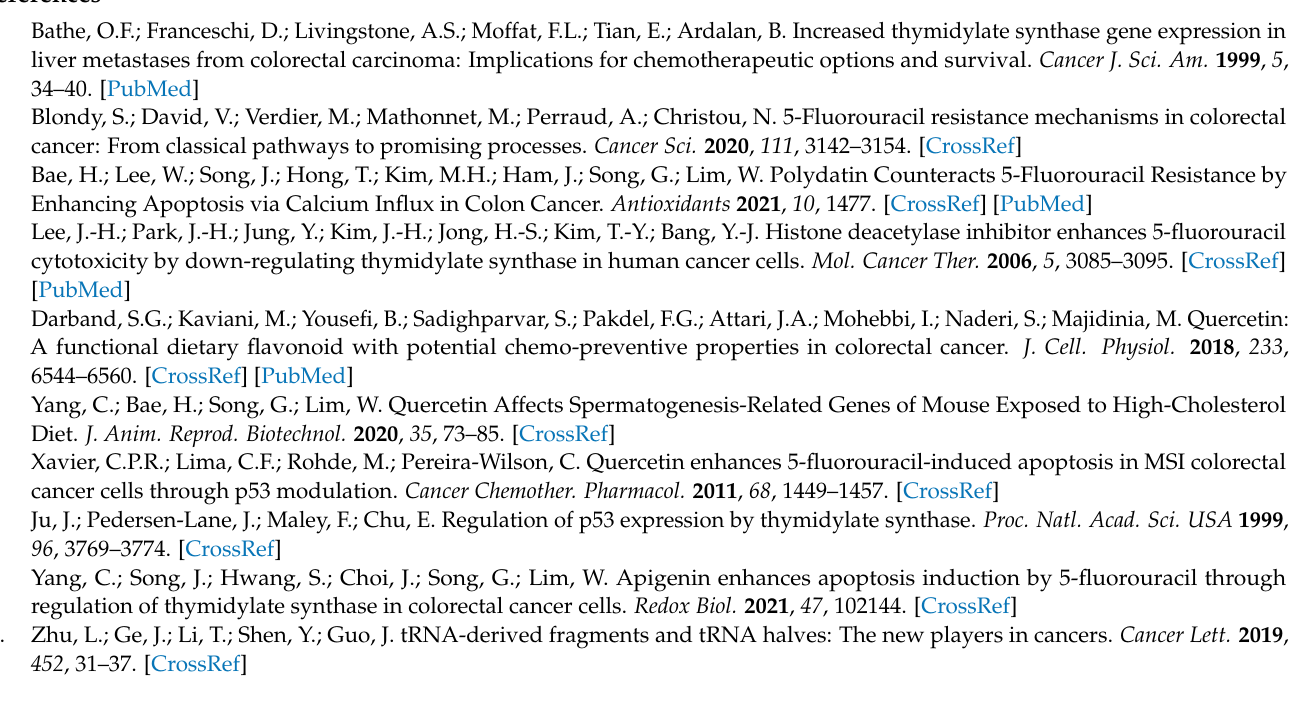
HT29 cells; Figure S3: Effects of 5-FU and quercetin on ROS production and intracellular Ca 2+ levels; Figure S4: Effects of 5-FU and quercetin on body weight and stool consistency in the colitis-associated CRC mouse